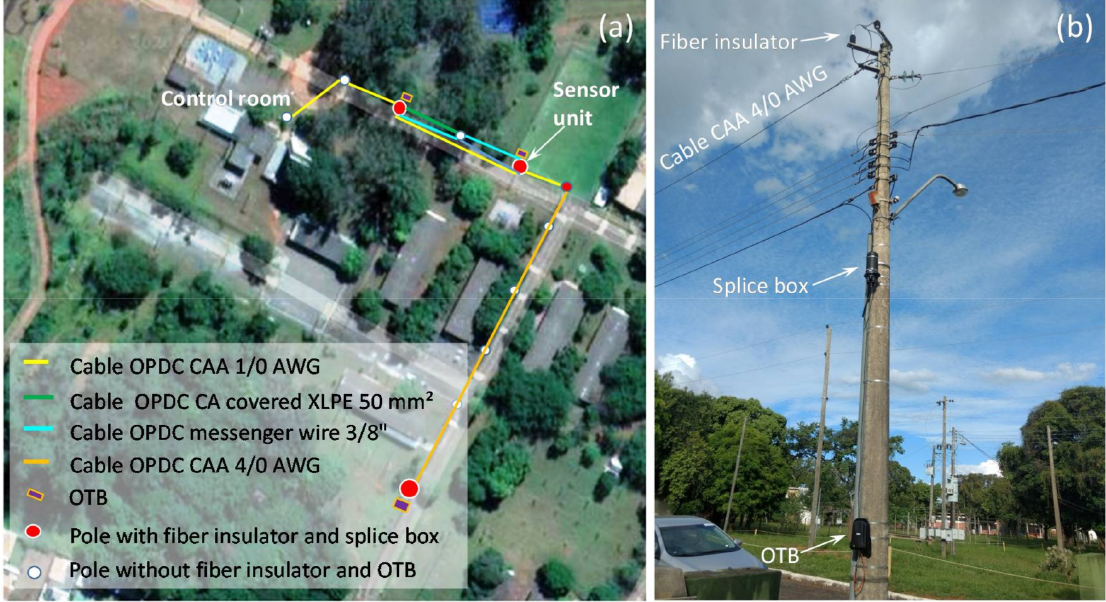
Figure A2. ( a ) Map of Synergistic Network and ( b ) photo of a pole with some elements of SN. Figure A2a shows the position of the sensor in the SN. The sensor was installed in a covered cable using a special tool to connect it to the medium voltage in a stirrup fixed in the cable (Figure